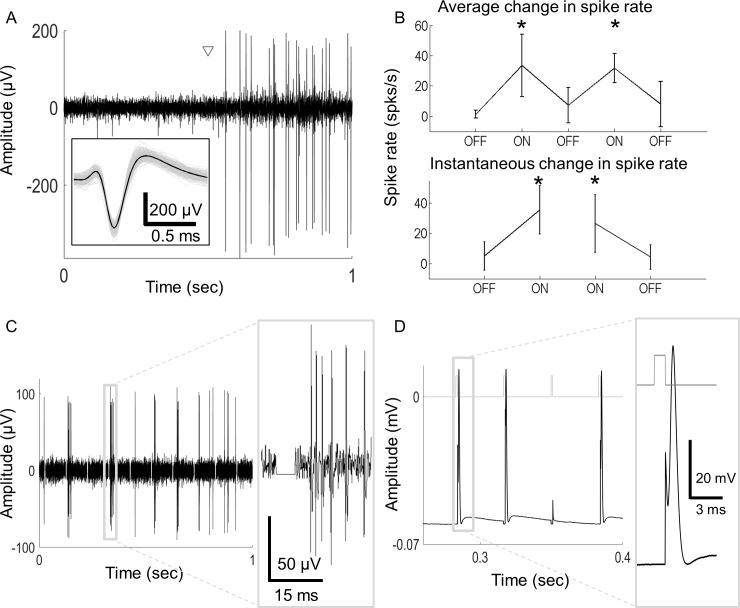
Sample light and electrical responses.A) An example ON cell responds with increased activity when light is switched on (onset marked with a triangle). The inset shows the overlaid spikes from a trial (gray) and the averaged response (black). B) The ON cell from A was stimulated with a spot of light centred at the electrode location. Light was switched on then off five times, each time for 10 s. The process was repeated seven times for this cell. Shown is the average spike rate during light off and light on periods (top) and the instantaneous spike rate 1 s prior to and after a change in illumination (bottom). Error bars represent standard deviations; * denotes a significant change in light on periods compared to light off (one-way ANOVA, p < 0.05). C) A sample cell showing the spikes in response to 10 electrical pulses over a 1 s period. Stimulation artefacts were removed online by blanking. Inset shows an expanded view of the stimulus artefact after removal. The remaining waveform reveals spikes detectable within 5 ms from stimulus onset. D) Intracellular recording showing action potentials (black trace) in response to electrical stimulation. Timing of electrical pulses is shown by traces at the top (grey). The expanded view shows how spikes can be detected with very low latency after artefact blanking.